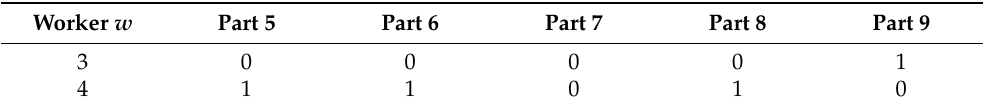
Table 10. Solution of worker-part assignment in Cell 2 obtained by using two-stage ALNS for the illustrative example.